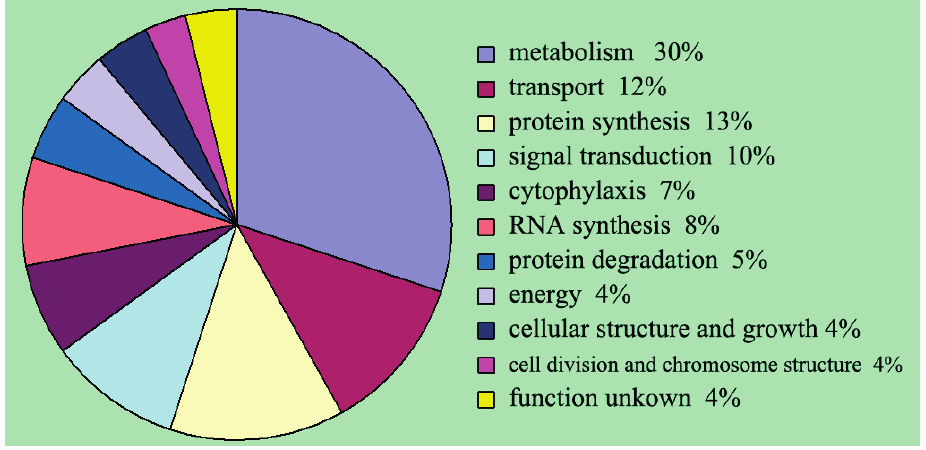
Figure 3. A graphical representation of sequence distribution based on Clusters of orthologous Groups of proteins